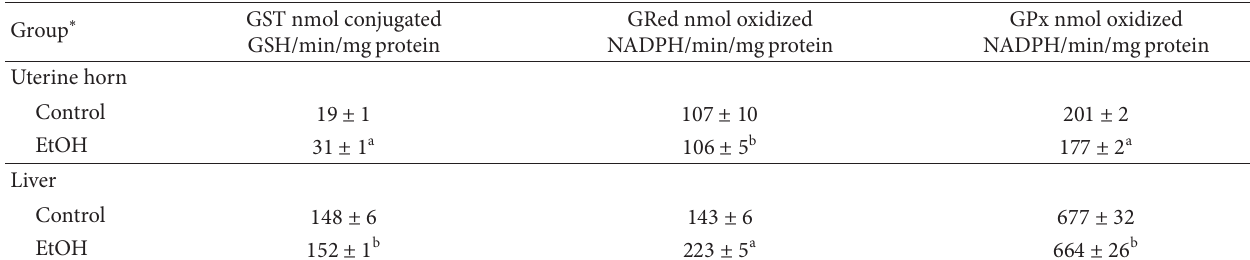
Table 6: Glutathione S-transferase activity (GST), glutathione reductase activity (GRed), and glutathione peroxidase activity (GPx) in uterine horn and liver tissue from rats receiving an ethanol containing liquid